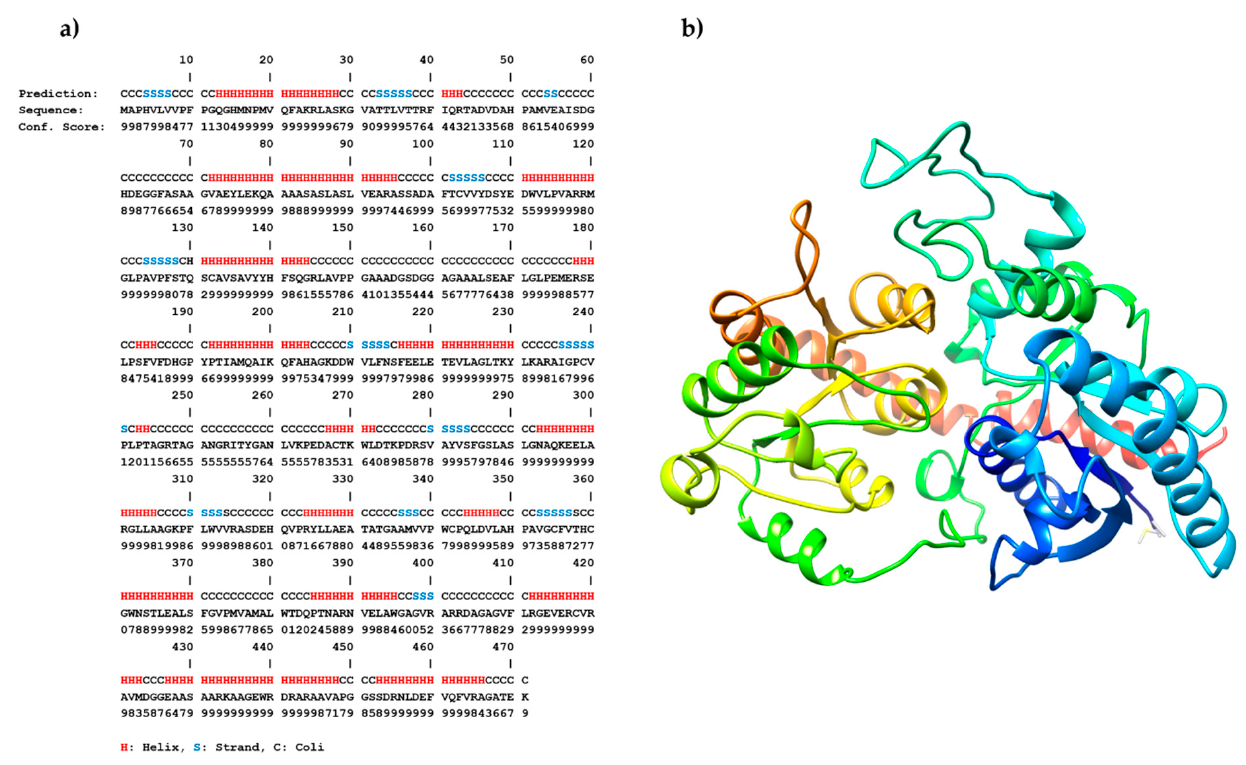
Figure 11. Three-dimensional structure of IAGlc synthase was modeled with the I-TASSER server (https://zhanglab.ccmb.med.umich.edu/I-TASSER/, accessed on 20 February 2021) [36–39]. The sequence-based prediction of the secondary structure using I-TASSER/PSSpred. The helix is marked in red, the strand is blue, and the coil is black ( a ). Predicted 3D model of IAGlc synthase in ribbon-style representation ( b ).